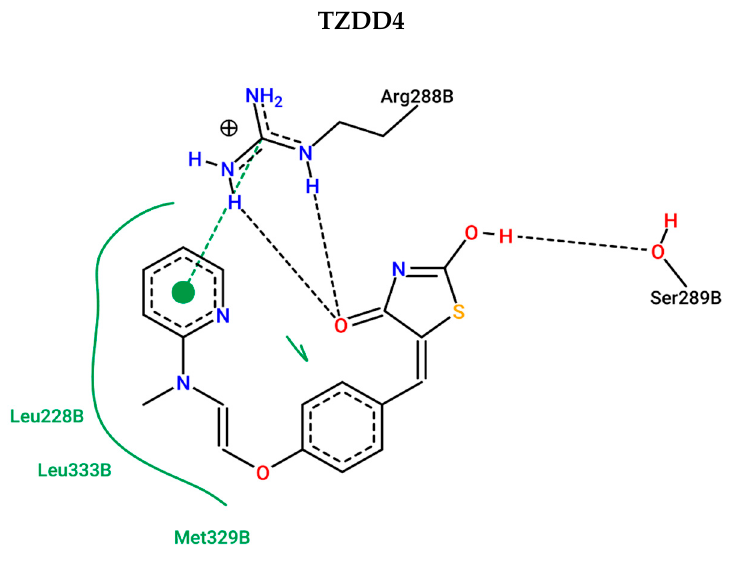
Figure 10. Conformations shows two-dimensional conformation diagrams of the TZD derivatives- PPAR- γ complexes. Dashed lines show directed bonds (hydrogen bonds and Ꙥ -cation interaction) PPAR- γ complexes. Dashed lines show directed bonds (hydrogen bonds and between the PPAR- γ protein and the ligand (TZZDs). between the PPAR- γ protein and the ligand Table 3. Low binding energies (LBE), estimated inhibition constants (EIC), and root-mean square deviations (RMSD) values of the TZD derivatives from the docking studies, temperature at 298.15 K.